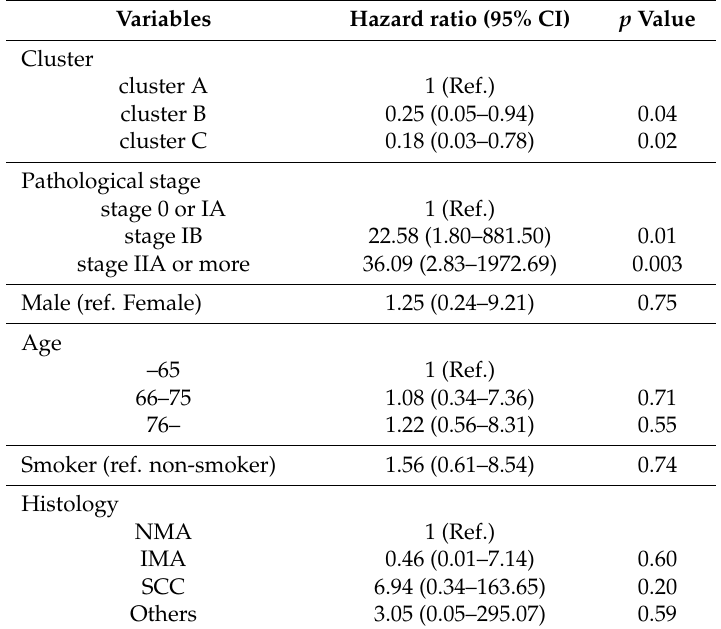
Table 3. Multivariate proportional hazard model of risk factors for postoperative recurrence or